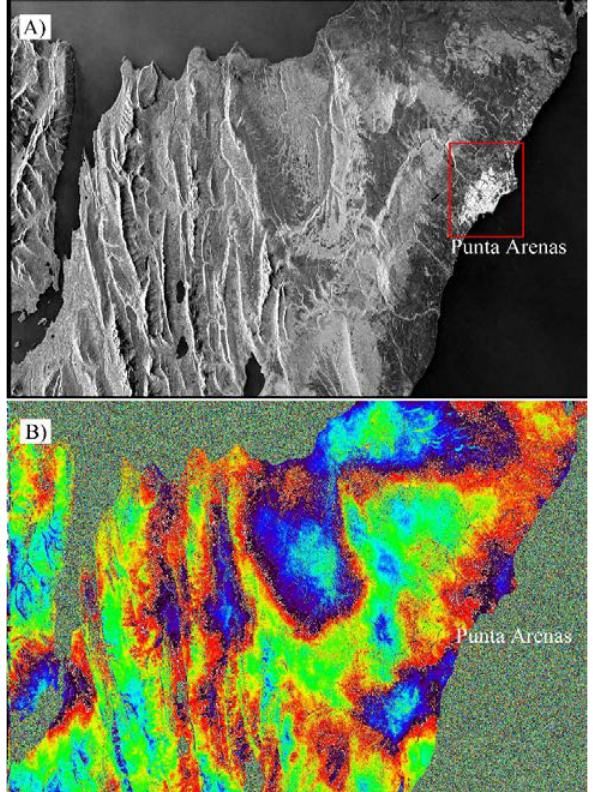
Figure 1. (A) Amplitude image of the Punta Arenas area. (B) 12-day